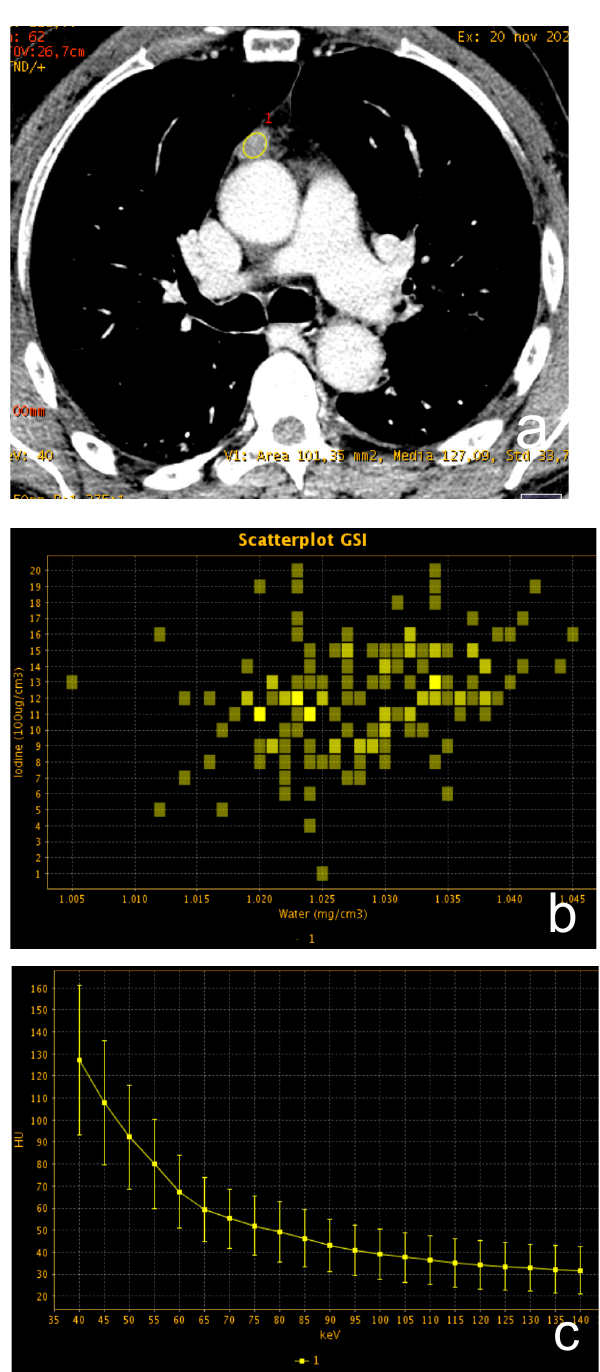
Figure 3. ( a – c ) A 62-year-old man with a small thymic lesion with convex margins. Dual-energy post-contrast images (scatterplot in ( a ) and spectral curve in ( b ) shows a mild enhancement of the lesion (mean iodine concentration 1.2 mg/dL). Histopathology revealed a medullary type A thymoma with capsule infiltration (Masaoka stage IIa). Concerning our topic of interest, a few studies investigated the potential of DECT for characterizing thymic lesions. Yen W. et al. investigated the efficacy of iodine quantification for differentiating thymoma, thymic carcinoma and thymic lymphoma. The authors enrolled 57 patients (16 low-risk thymomas, 15 high-risk thymomas, 14 thymic carcinomas and 12 lymphomas). All patients underwent dual-phase post-contrast DECT scans in arterial and venous phases, and the following parameters were analyzed: iodine-related Hounsfield Unit (IHU), iodine concentration (IC), mixed HU (MHU), slope HU curve and virtual non contrast (VNC) values. The results demonstrated that IHU, IC and MHU were significantly higher in patients with low-risk than high-risk thymoma, thymic carcinoma and lymphoma: IHU in the venous phase showed the best performance for differentiating low-risk thymomas from the other tumors, with an AUC of 0.893 and a cut-off of 34.3 HU, while IC in the venous phase performed well for differentiating low-risk thymoma from lymphoma, with an AUC of 0.969 and a cut-off of 1.25 mg/mL. The higher values of DECT parameters in low- risk thymomas can be explained by the high prevalence of short-spindled variant among types A and AB thymomas, which are composed by short spindle cells arranged in a hemangiopericytic structure with a rich vascularization [20]. Xie Y. et al. [21] investigated the possibility of DECT to distinguish thymoma from mediastinal lymphoma because there is a significant overlap between the two diseases on conventional single-energy contrast CT. A total of 39 patients (24 with thymoma and 15 with lymphoma) were enrolled. DECT scans of the thorax were performed both in post- contrast arterial and venous phases by using fast tube voltage switching between 80 and 140 kVp. The following parameters were assessed for each lesion: normalized IC (NIC), calculated as the ratio between IC of the lesion and aorta, slope of spectral curve between 40 and 140 keV and CT attenuation difference, which is the difference in attenuation between arterial and venous phase at 70 keV. Data analysis showed a significant difference in NIC between patients with thymoma and lymphoma in venous phase (0.49 ± 0.15 mg/mL vs. 0.28 ± 0.08 mg/mL, respectively) and a significant higher slope of the spectrum curve in patients with thymoma in arterial phase. The higher IC of thymoma in the venous phase can be explained by the coexistence of neoplastic cells and fibrous bands within thymic lobules, which delay the washout of contrast medium. On the contrary, lymphomatous tissue lacks fibrous septa, and therefore the lesion washes out quickly after arterial phase. 4. CT Perfusion